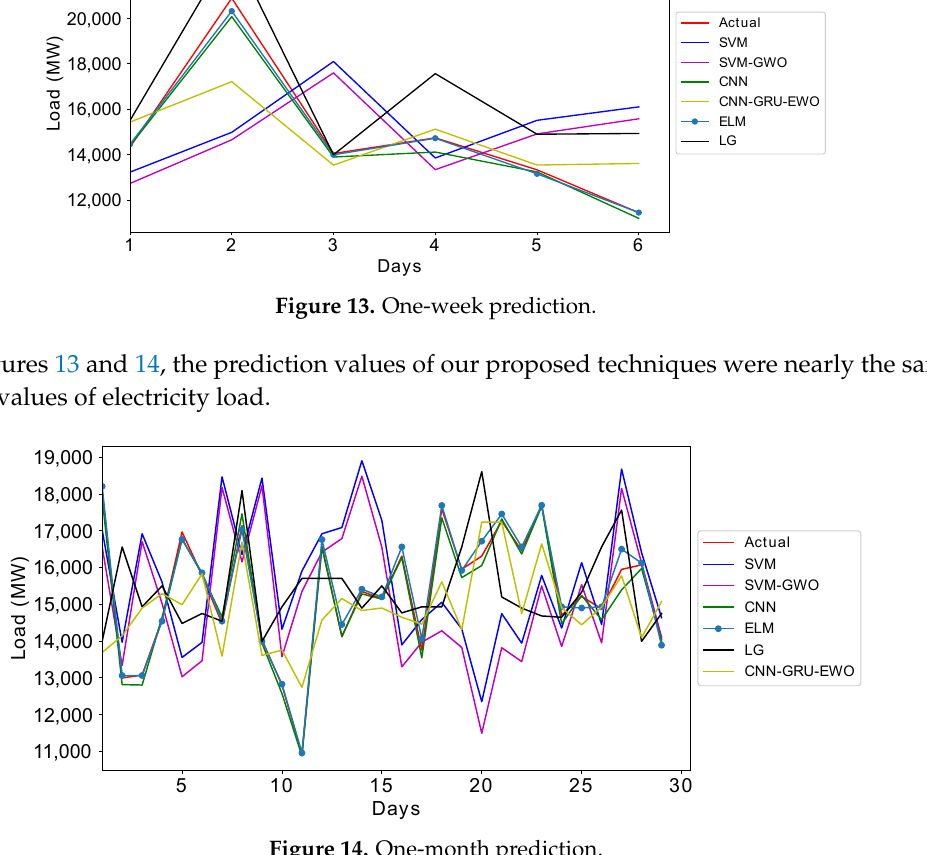
Figure 14. One-month prediction.